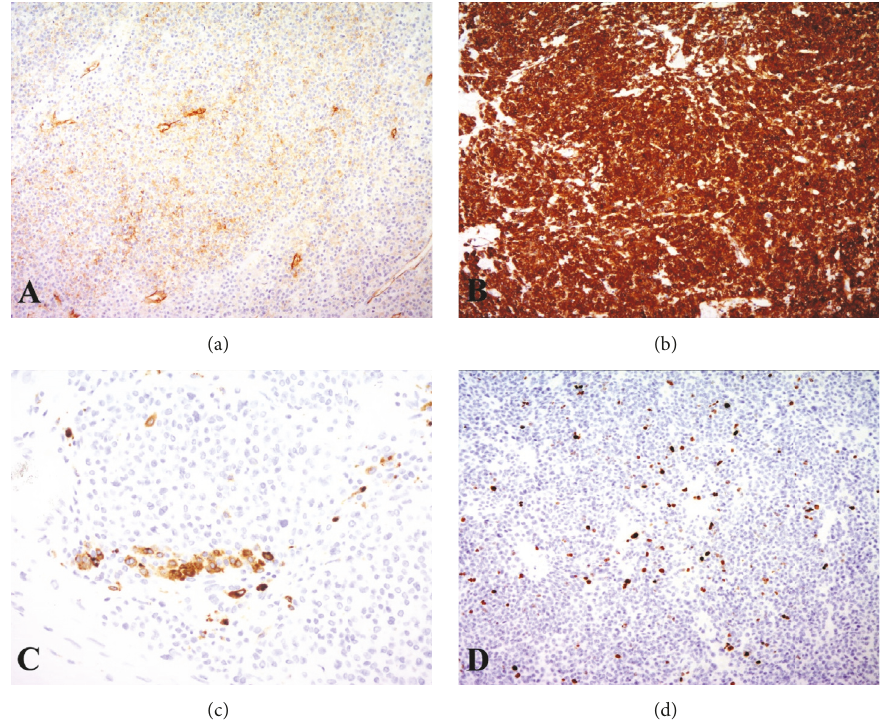
Figure 5: Immunohistochemical analysis. Tumor cells are positive for (a) CD34, (b) SMA, and (c) Renin. (d) MIB1 labeling index was 4% ((a, b, d): x10, (c): x20).